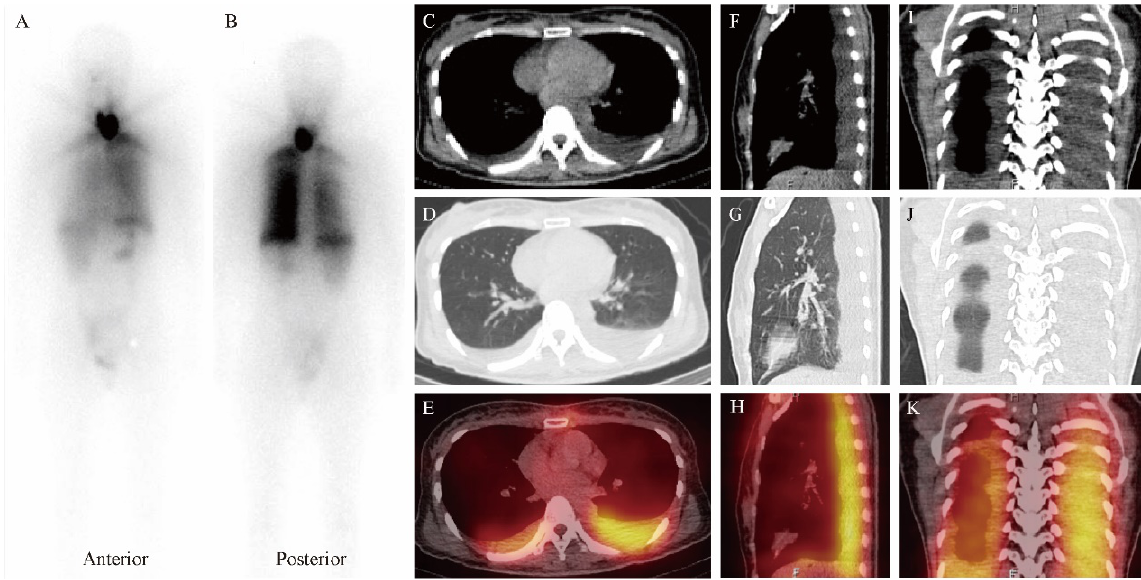
, free thyroxine (normal range: 7.50–21.10 pmol/L); TSH, 4